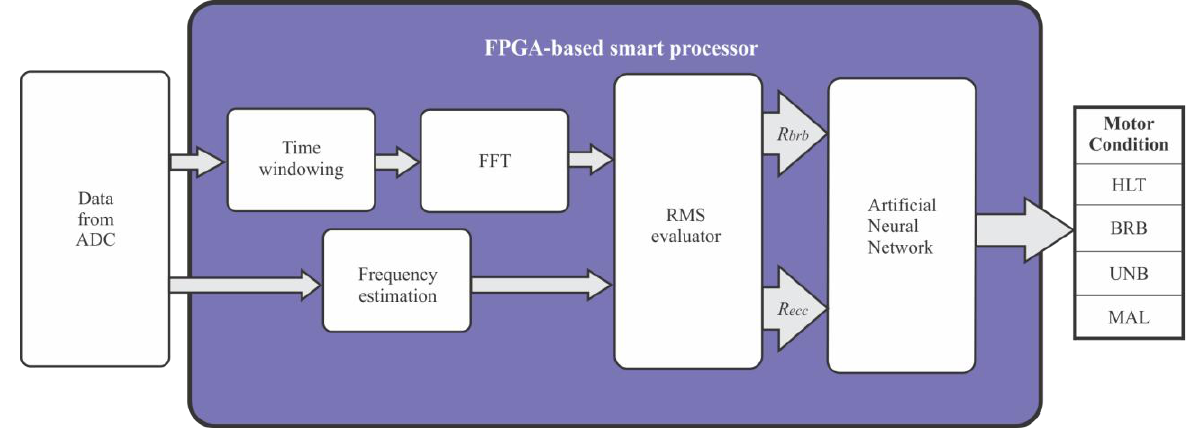
Figure 5. Block diagram of the FPGA-based smart processor.